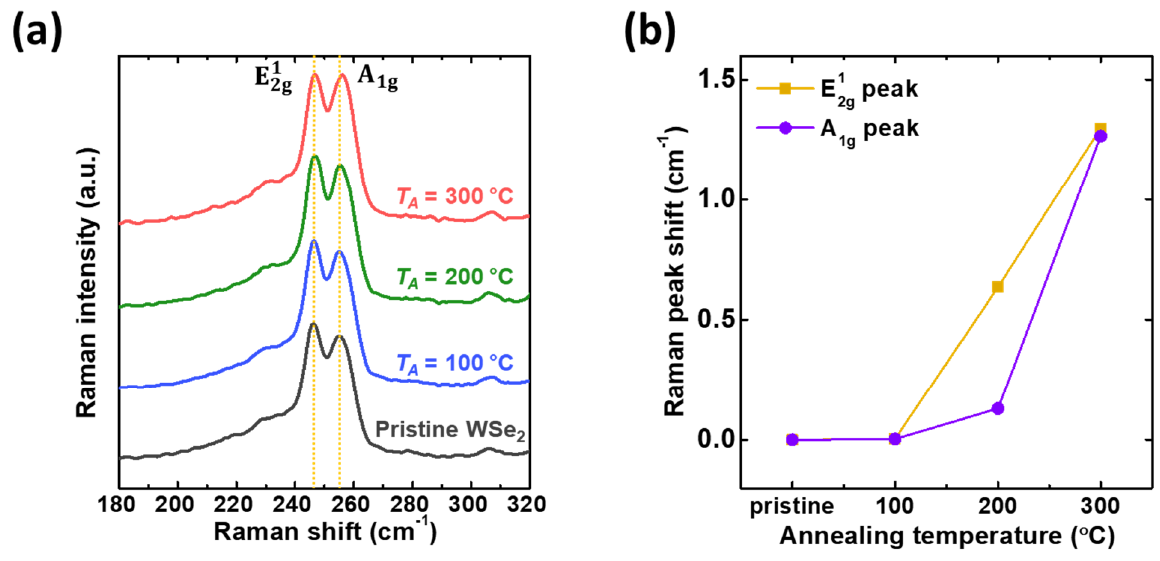
Figure 5. ( a ) Raman spectra of pristine WSe 2 and F-WSe 2 ( T A = 100, 200, and 300 ◦ C) and ( b ) Raman peak shift data for E 2g1 and A 1g modes.